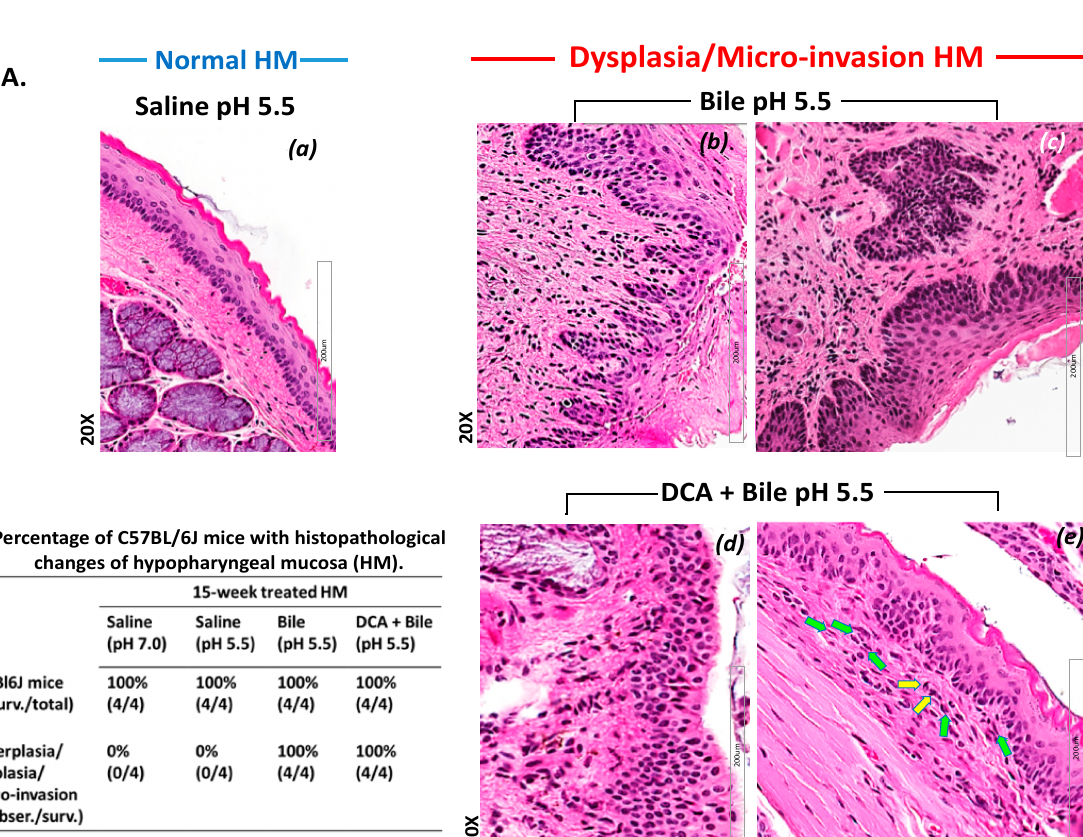
Figure 1. Weakly acidic bile-induced pre-malignant changes in murine hypopharyngeal squamous mucosa (HM) of C57Bl/6J mice ( A ). (H&E staining) (from left to right). Normal HM: ( a ) keratinized stratified squamous epithelium/single layer of basal cells; Dysplastic HM : ( b ) mild dysplastic epithelium with rete ridges shape; ( c ) thickness of stratified epithelium and hyperchromatic or pleiomorphic basal cells extend into the upper layers of the mucosa and well differentiated squamous epithelial cells forming islands with architectural changes in submucosa and underlying muscle with hyperchromatic nuclei. Dysplasia-Micro-invasion: ( d ) submucosal invasion by basal cells while HM maintaining full thickness nuclear hyperchromatism without surface maturation, and ( e ) atypical neoplastic cells in the submucosa characterized by mitotic figures (yellow arrows) and possible intercellular bridges of the atypical cells (green arrows). ( B ). Percentage (%) of C57BL/6J mice exhibiting histopathological alterations of HM after 15 weeks of exposure.